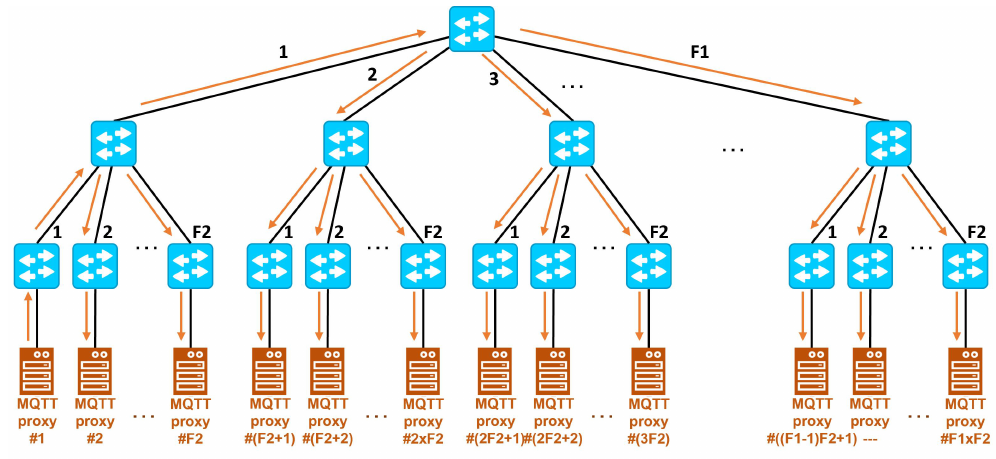
Figure 14. Packets retransmitted within the SDN network due to one incoming packet using multicast, e.g., with our MQTT proxies.